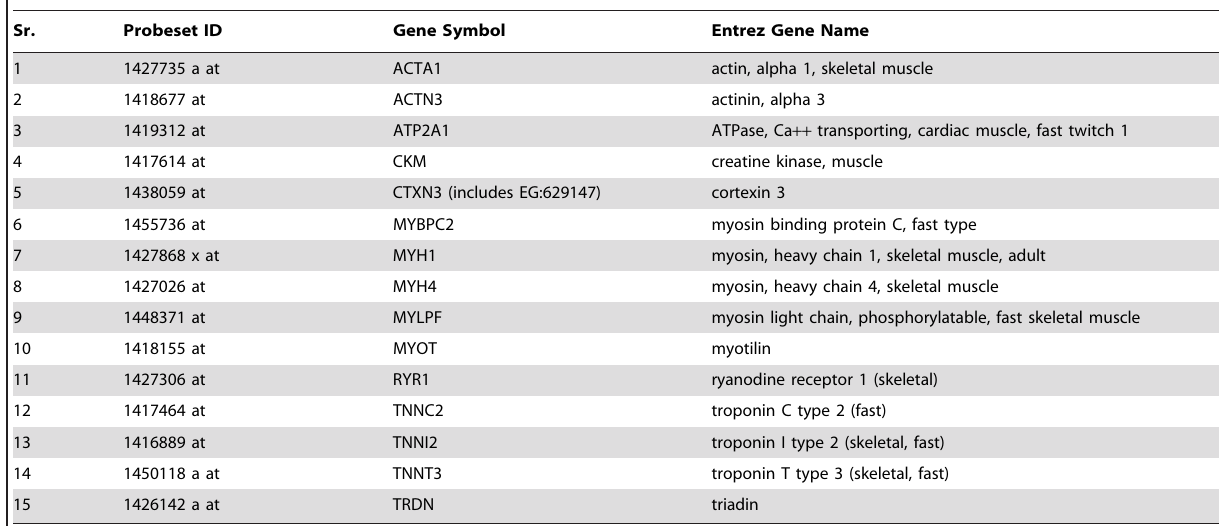
Table 12. Muscle 1 muscle 4 cluster 1.